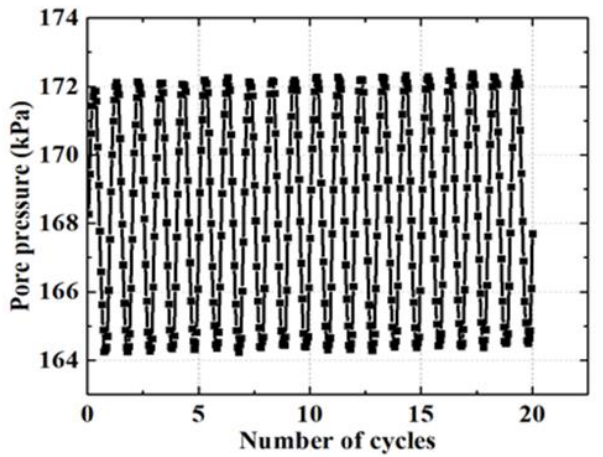
Figure 6. Pore pressure cycle curve of the first 20